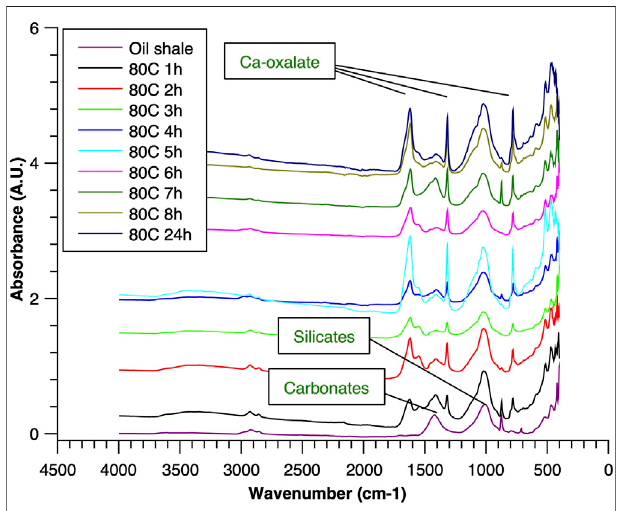
FIGURE 3 | ATR – FTIR of oil shale and reaction residues at 80 ° C.